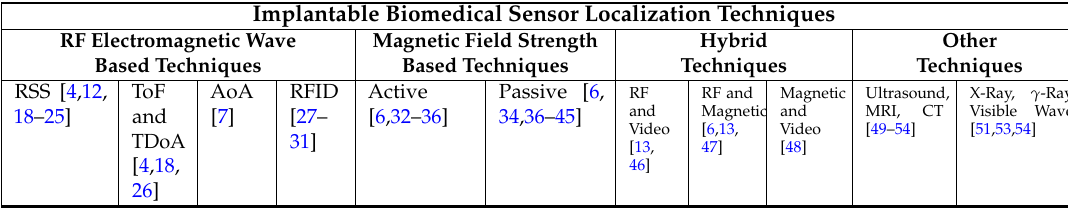
Table 1. Implantable biomedical sensor localization techniques in the